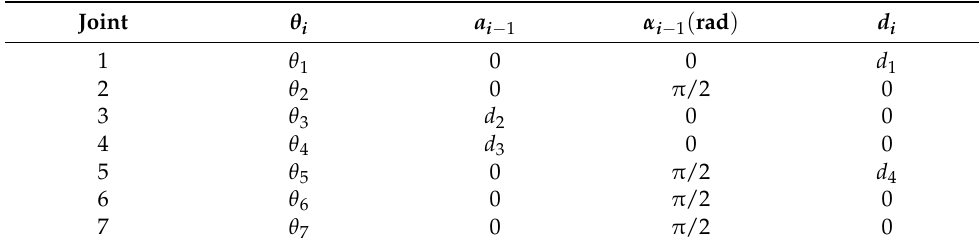
Table 1. D–H parameters of a 7-DOF manipulator.